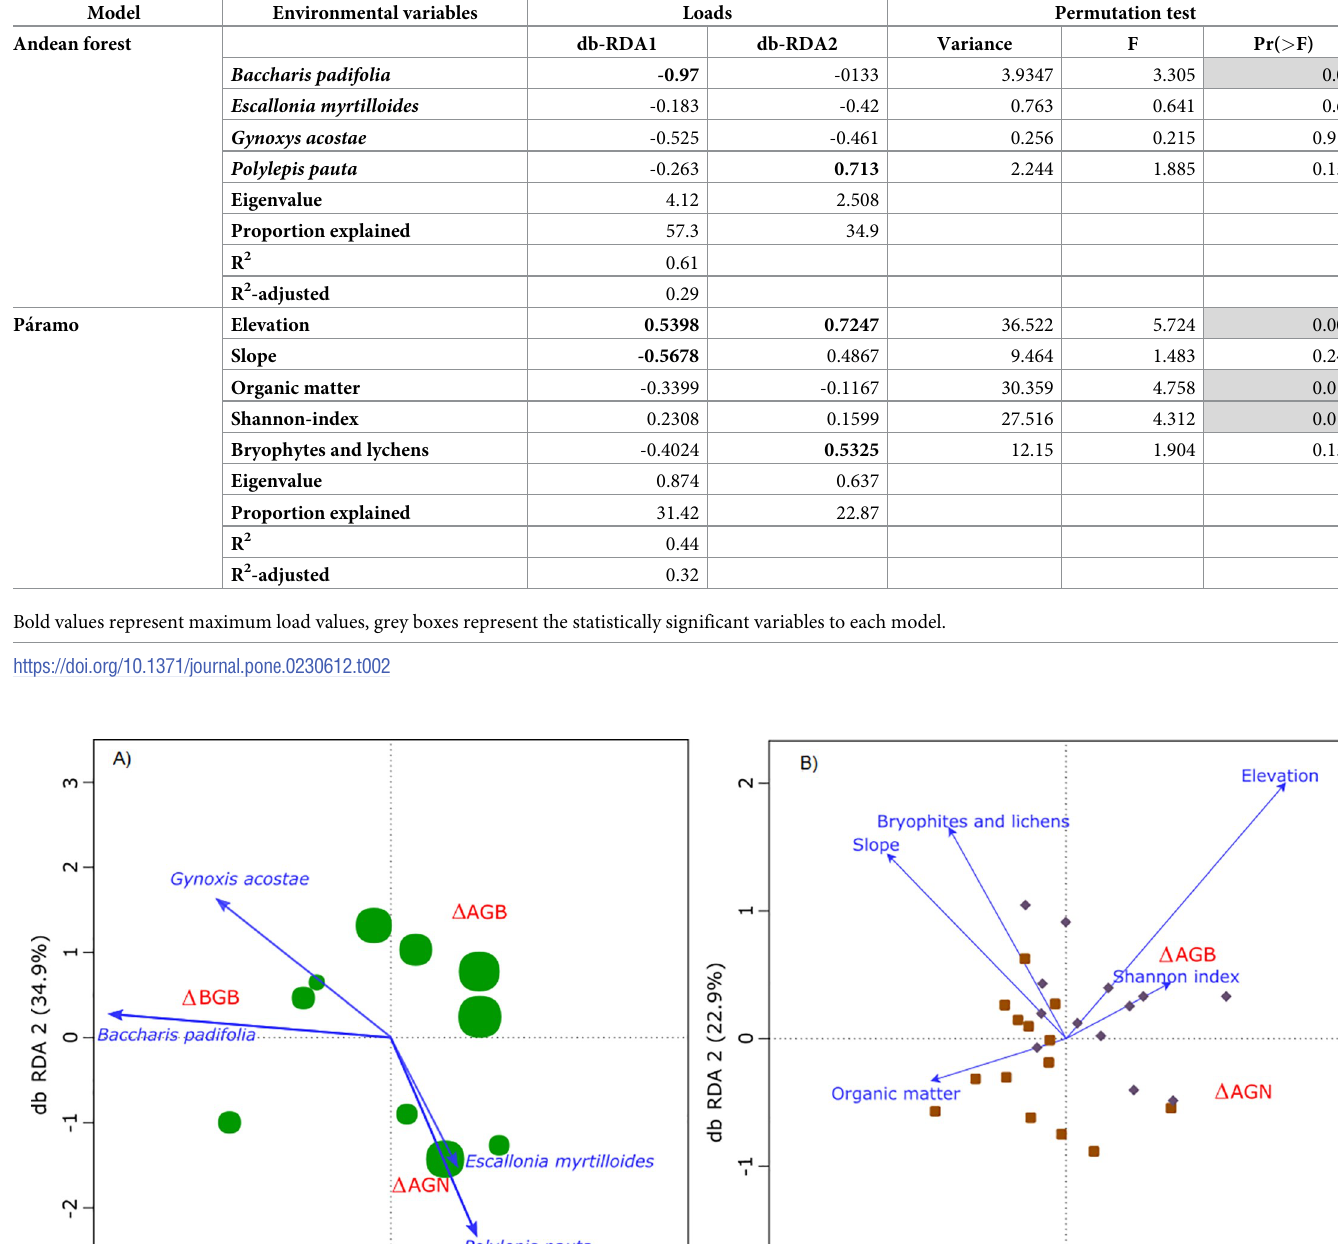
Table 2. Loads, eigenvalues and significance level of the distance-based RDA including the environmental variables analyzed for testing the influence over carbon stock differences for both ecosystems, Andean forest and pa´ramo.